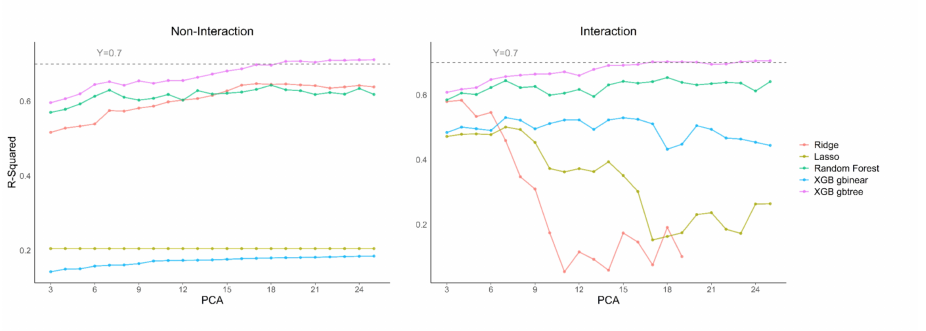
Figure 6. Results of different regression methods measured by R-squared.